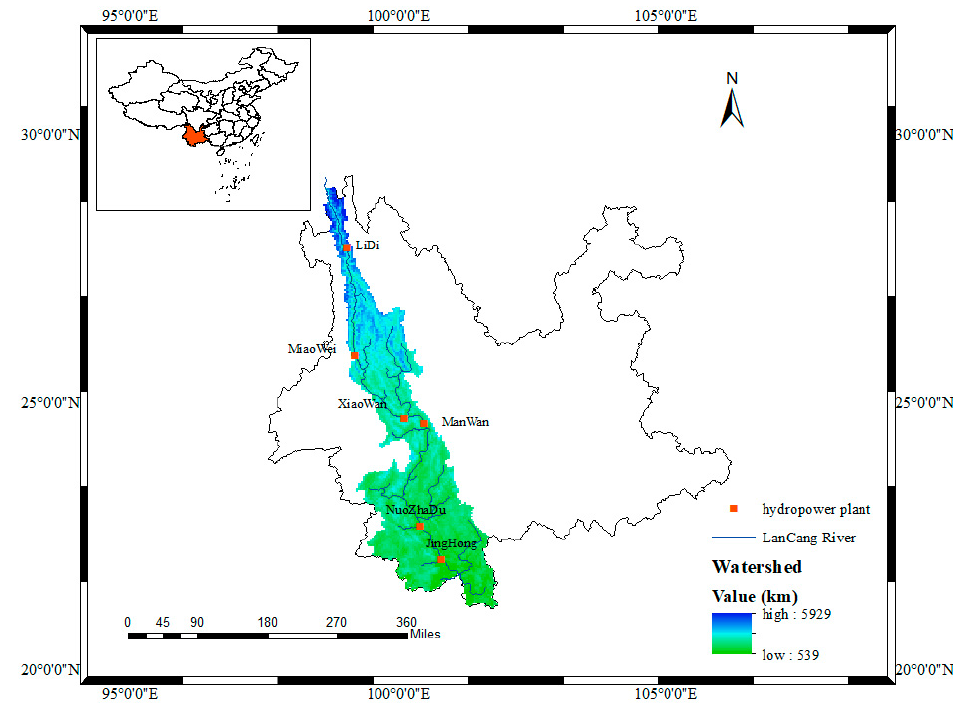
Figure 2. Locations of the six hydropower plants on the Lancang River.